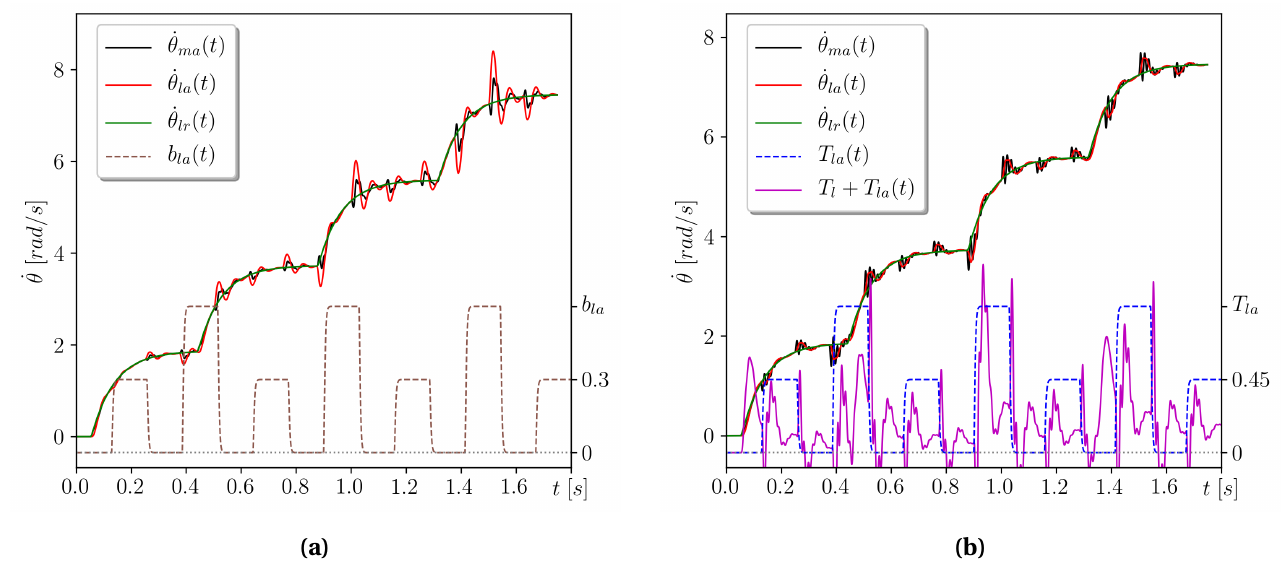
Figure 10. The closed-loop reference model control system response at the presence of b la ( t ) (a) and T la ( t ) (b) disturbance and a PID regulator (high frequency) – see case A in the block diagram in Figure 3.